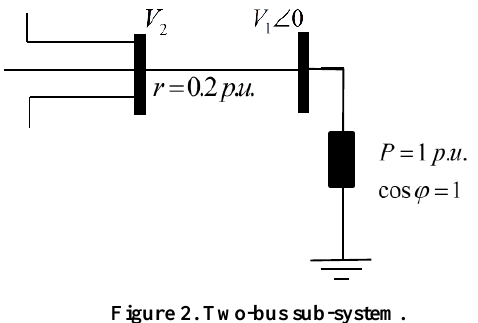
Figure 2. Two-bus sub-system.